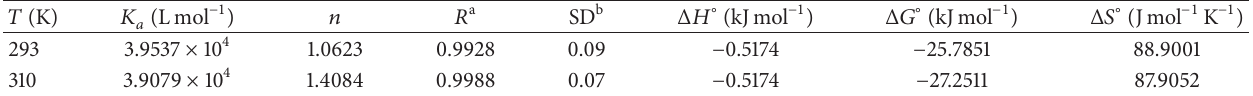
a The correlation coefficient. b The standard deviation.